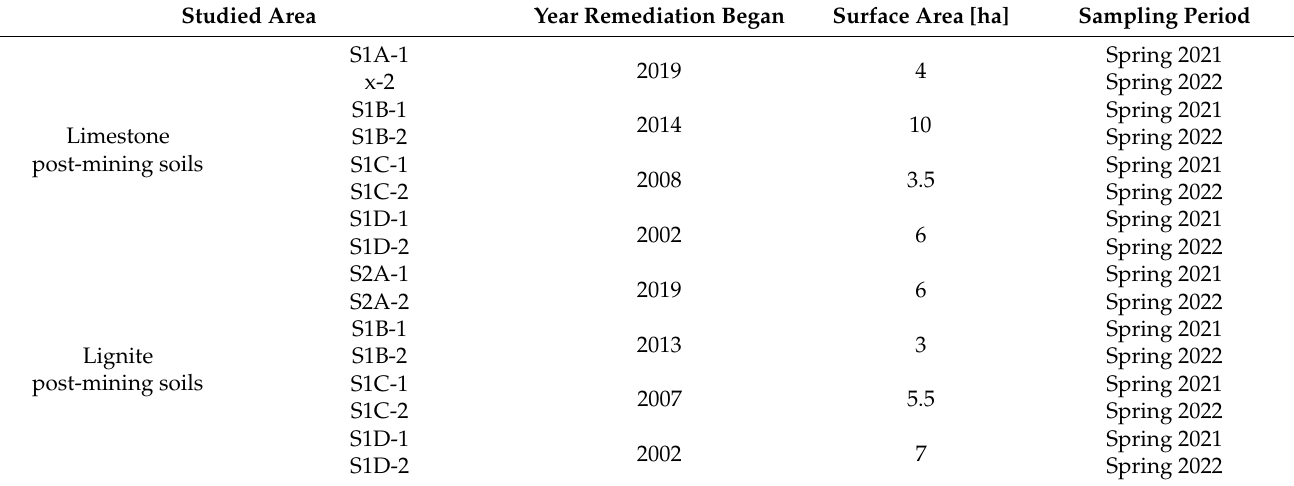
Table 1. The characteristic of studied